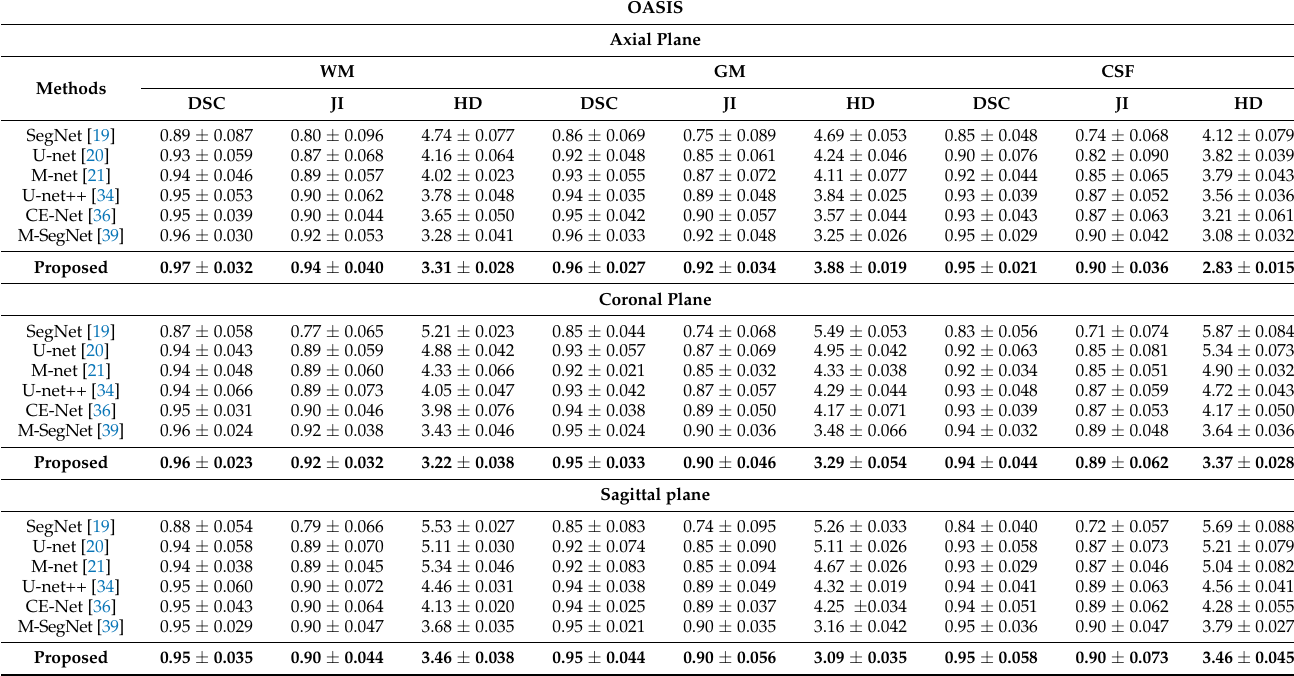
Table 2. Segmentation accuracy comparison for the proposed and conventional methods on OASIS and IBSR